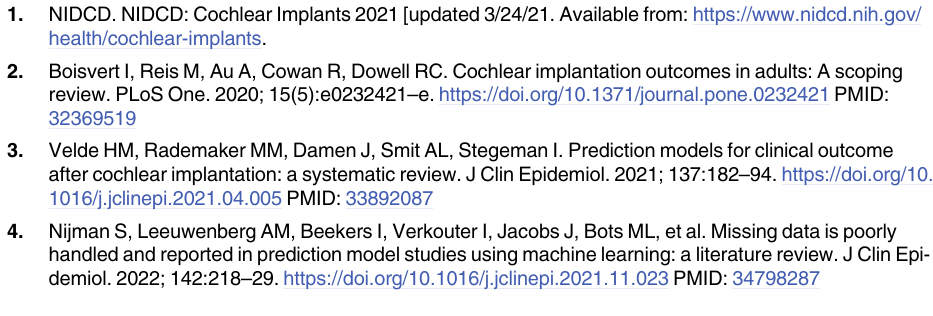
S2 Table. Demographics, numerical. Summary statistics for age, duration of hearing loss, audiometry, and speech perception testing. Measures of speech perception included conso- nant-vowel nucleus consonant (CNC) test and the Arizona Biomedical Sentence (AzBio) test in quiet and with +5dB or +10dB of background